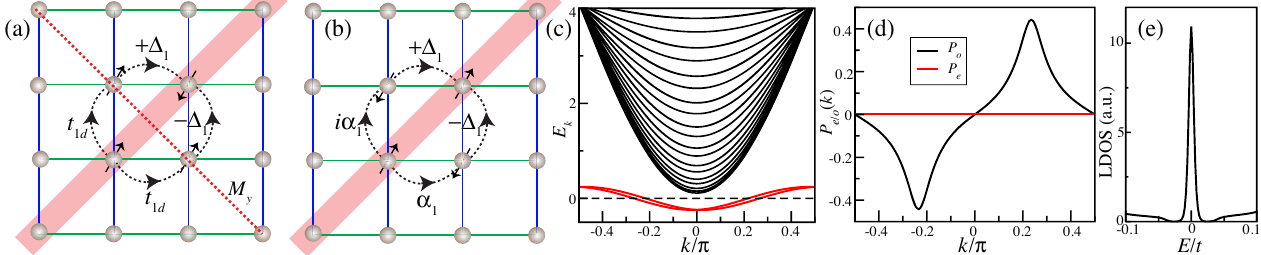
FIG. 8. (a),(b) Schematic illustration of a nodal RALD embedded in the nodal direction of a d -wave superconductor. The mirror operation M y is indicated by the red dashed line in (a). The pairing amplitudes on the green and blue lattice bonds have opposite signs. The two processes for spin-singlet pairing along the RALD cancel in (a), and the two processes shown in (b) contribute to spin-triplet pairing along the RALD. (c) Band dispersions for the normal state in the (1,1) direction in the 2D system with L large L D ¼ L so that k is continuous. The red lines correspond to the dispersions of the incipient impurity bands split by Rashba ð 1 ; 1 Þ SOC. The black lines are the dispersions of the bulk bands. (d) Expectation values of the induced pairing order parameters in the RALD for the even-parity P e ð k Þ and odd-parity P o ð k Þ , where P e ð k Þ is zero due to symmetry. (e) The LDOS spectrum at either end of the line defect with a temperature broadening T ¼ 0 . 0025 . Parameters used are μ 0 ¼ − 4 . 1 , μ d ¼ − 0 . 3 , t 1 ¼ − 1 , t 2 ¼ 0 , t 0 2 ¼ − 0 . 1 , t